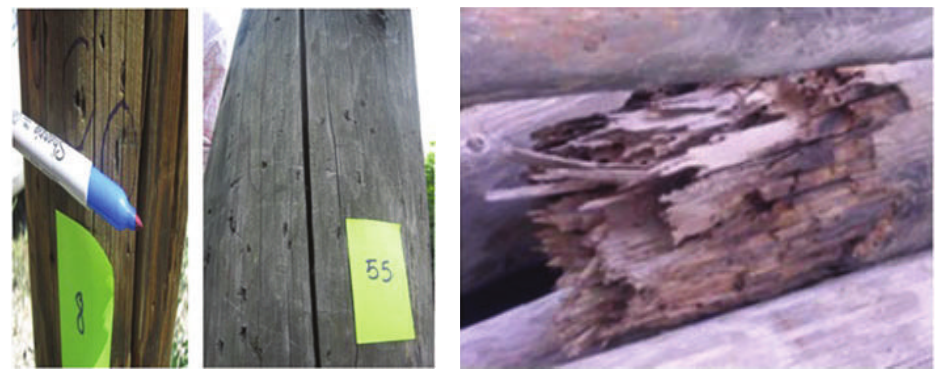
Figure 5: Insect attacks on the utility